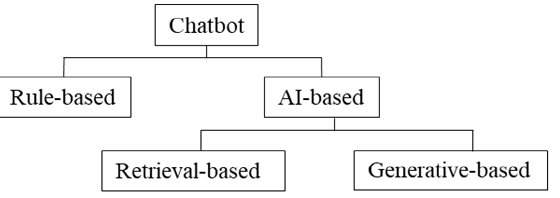
Figure 2. Classification of chatbots based on design techniques.